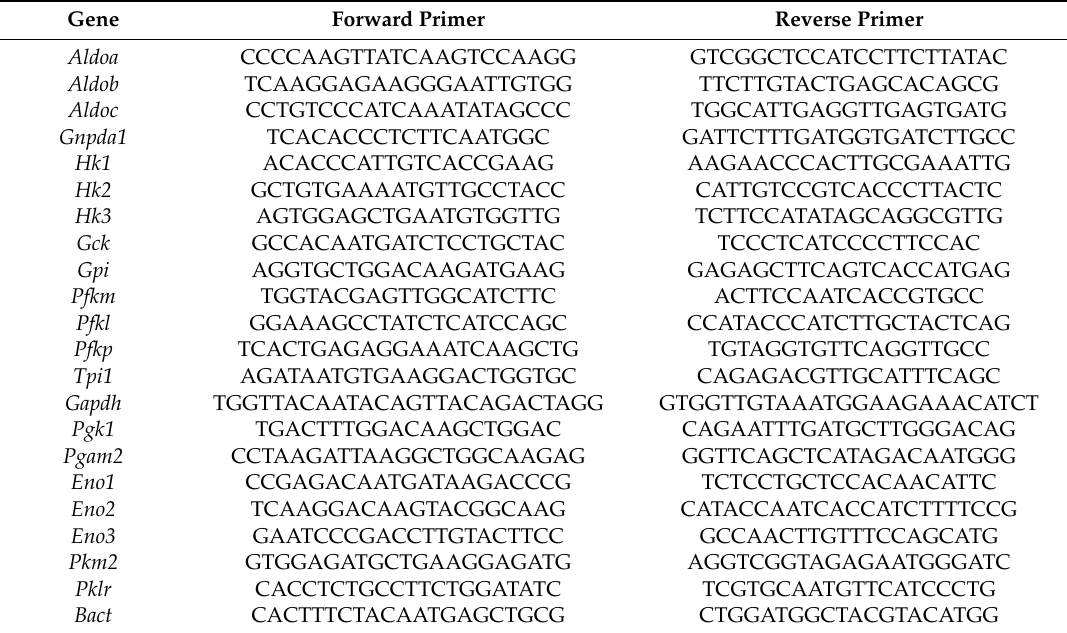
Table 4. Primer sequences used for RT-qPCR analysis of glycolytic pathway